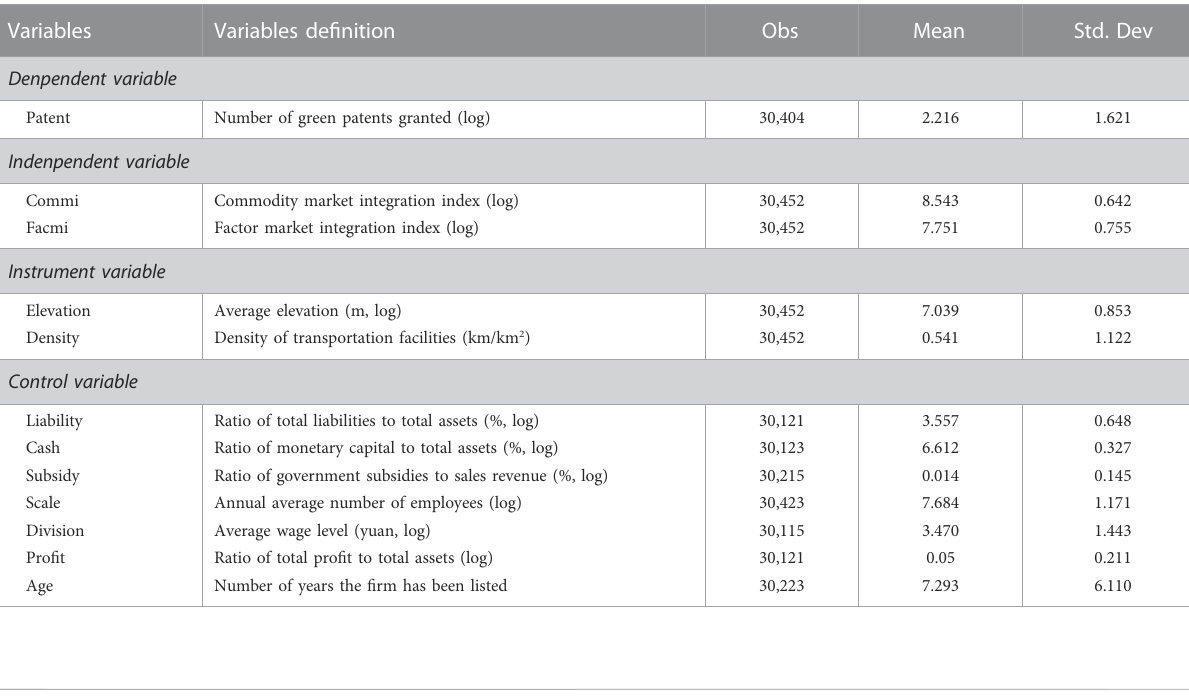
TABLE 1 Descriptive statistics.